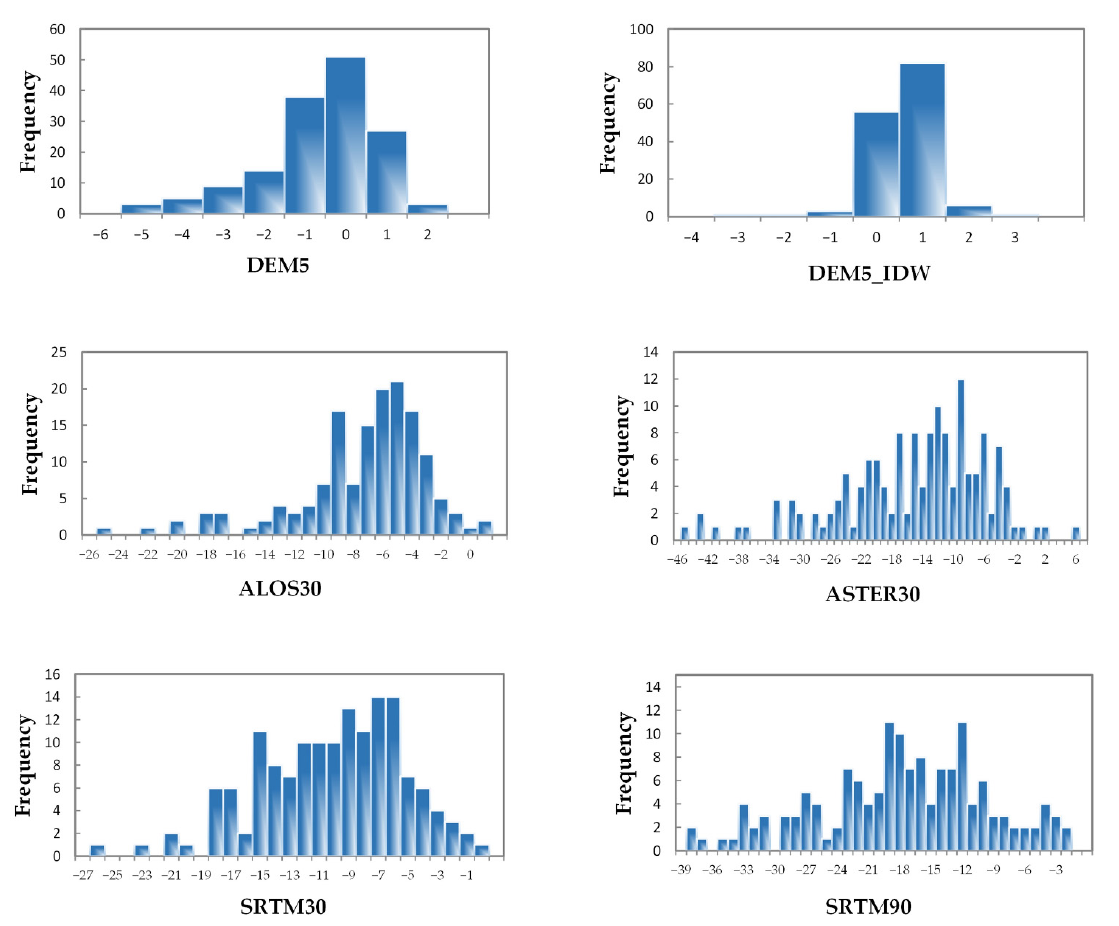
Figure A1. Histograms of the error ( ∆ h) for all the DEM data (DEM5, DEM5_IDW, ALOS30, ASTER30, SRTM30 and SRTM90) showing the non-normality of the error distribution.